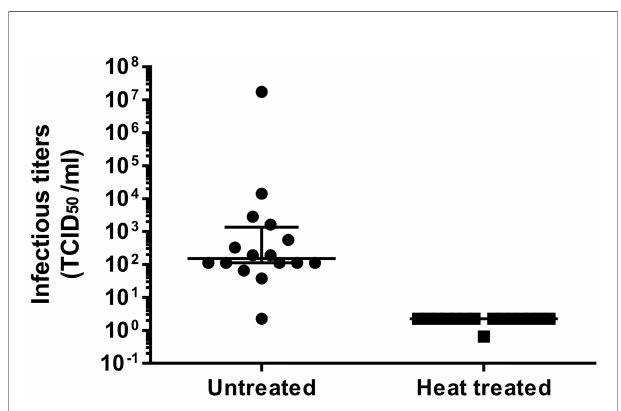
FIGURE 5 | Effect of heat inactivation on HIV-1 infectivity. Supernatants were harvested at 7 and 14 days in coculture. Those over 10 6 HIV RNA copies/ml were mixed, when possible, after inactivation. The graph shows TCID50/ml prior (left half, untreated) and after heat inactivation (right half, heat treated). Longer solid lines at both graph halves correspond to the median TCID50/ml for each group, while the upper and lower solid lines on the left indicate the 75% and 25% IQR percentiles,